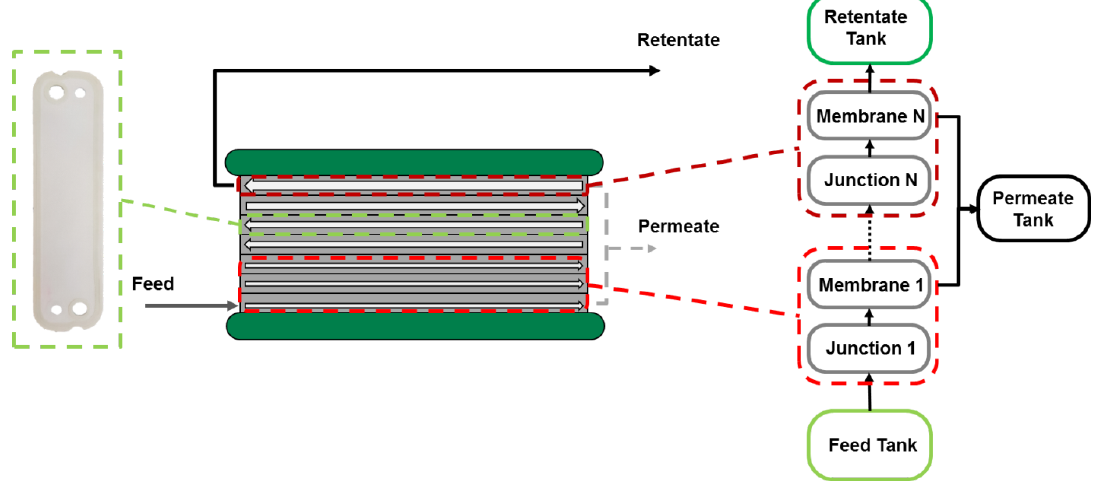
Figure 4. SPTFF module modelling approach.